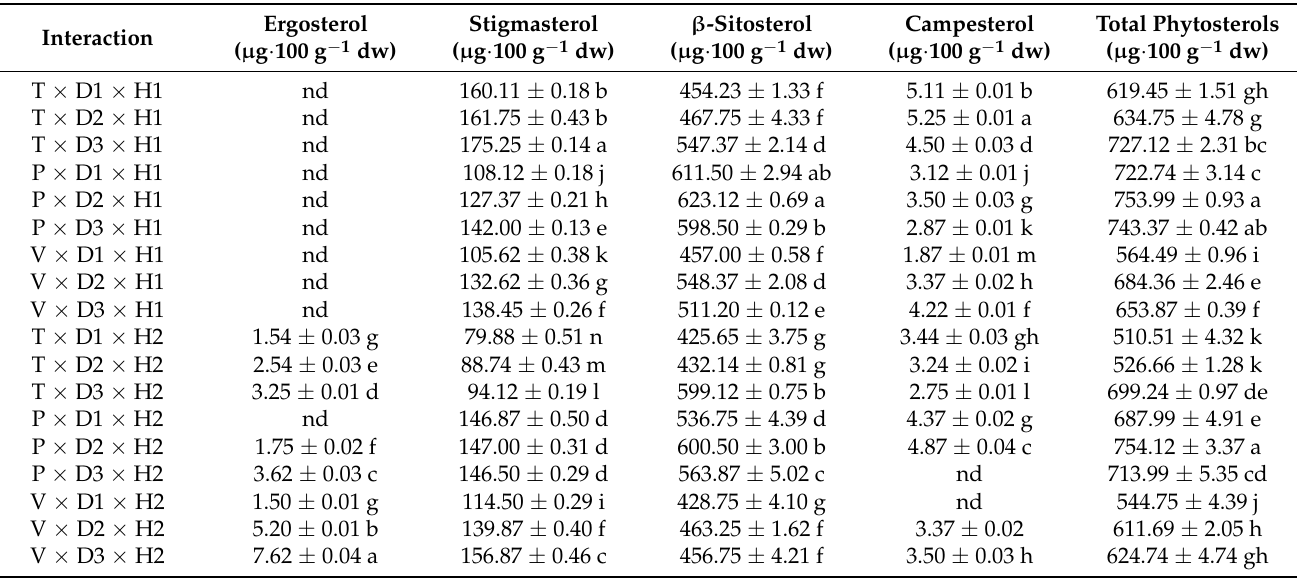
Table 6. Cultivar, plant density and harvesting time interaction effect on phytosterol compounds of quinoa leaf